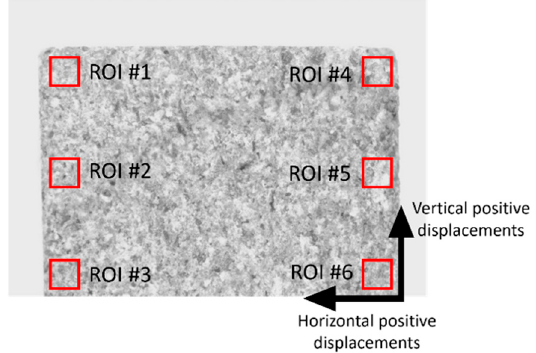
Figure 5. Number and location of ROIs for which the image processing was done and the direction of the positive displacements.